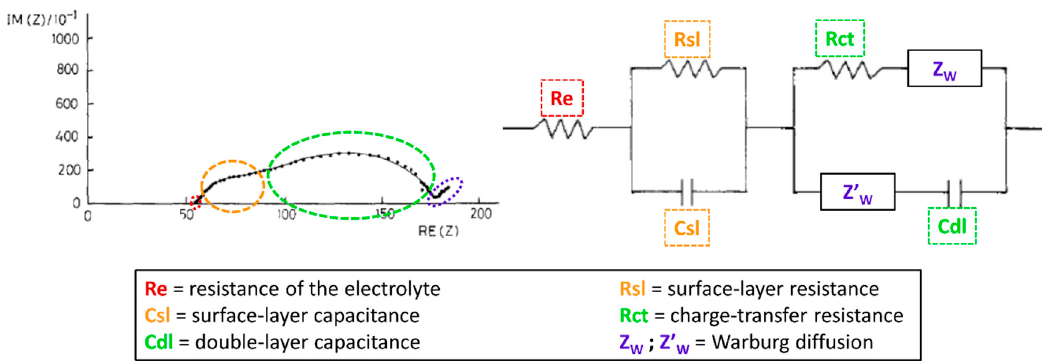
Figure 5. Experimental and fitted impedance response for a Co-containing positive LIB electrode ( left ). Equivalent circuit used to fit the experimental data ( right ). Figure adapted with permission from [51].